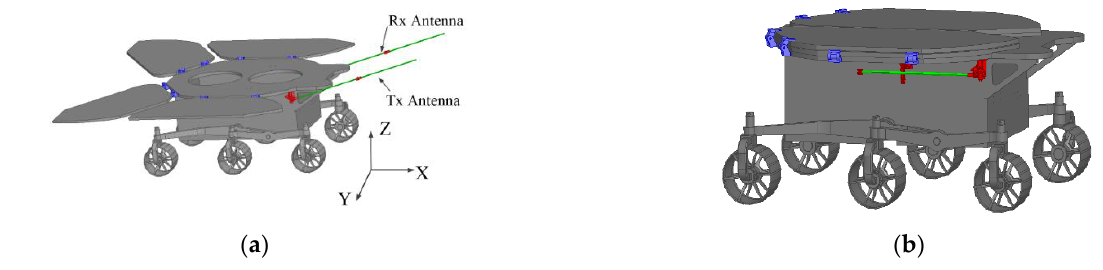
Figure 2. Positions of the antennas on the Rover. ( a ) Deployment status. ( b ) Folded status.